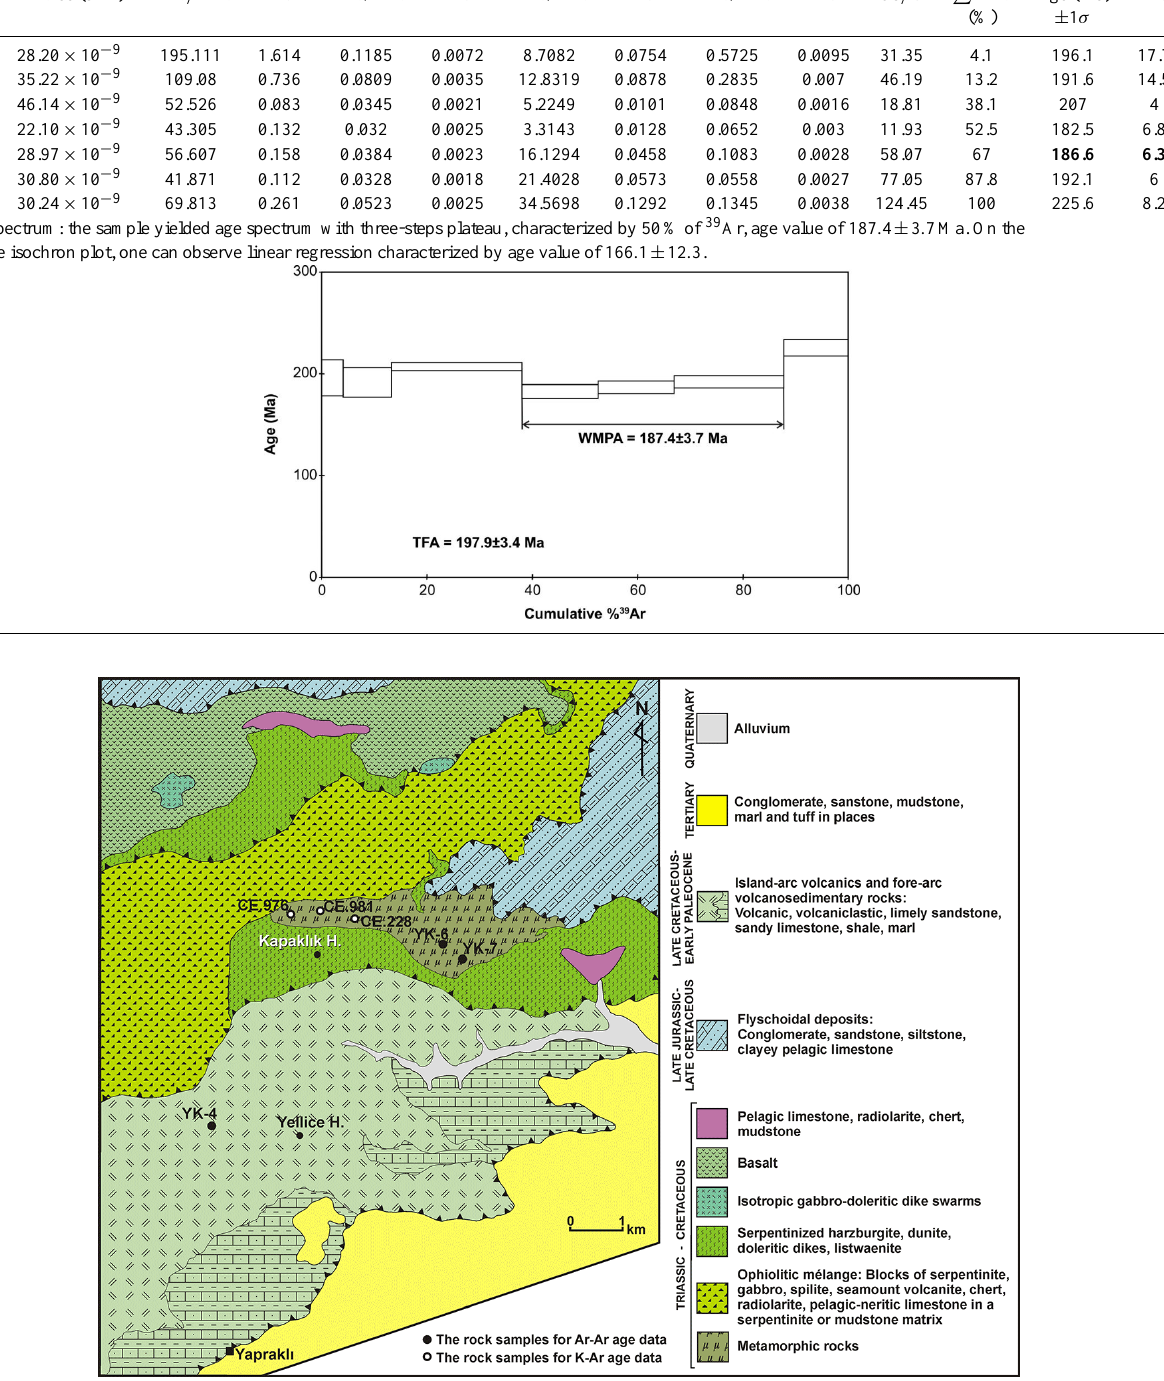
Fig. 6. Simplified geological map of the Yapraklı–Çankırı area, showing the distribution of the ∼ 180Ma Neotethyan ophiolitic units, ophi- olitic mélange and island arc